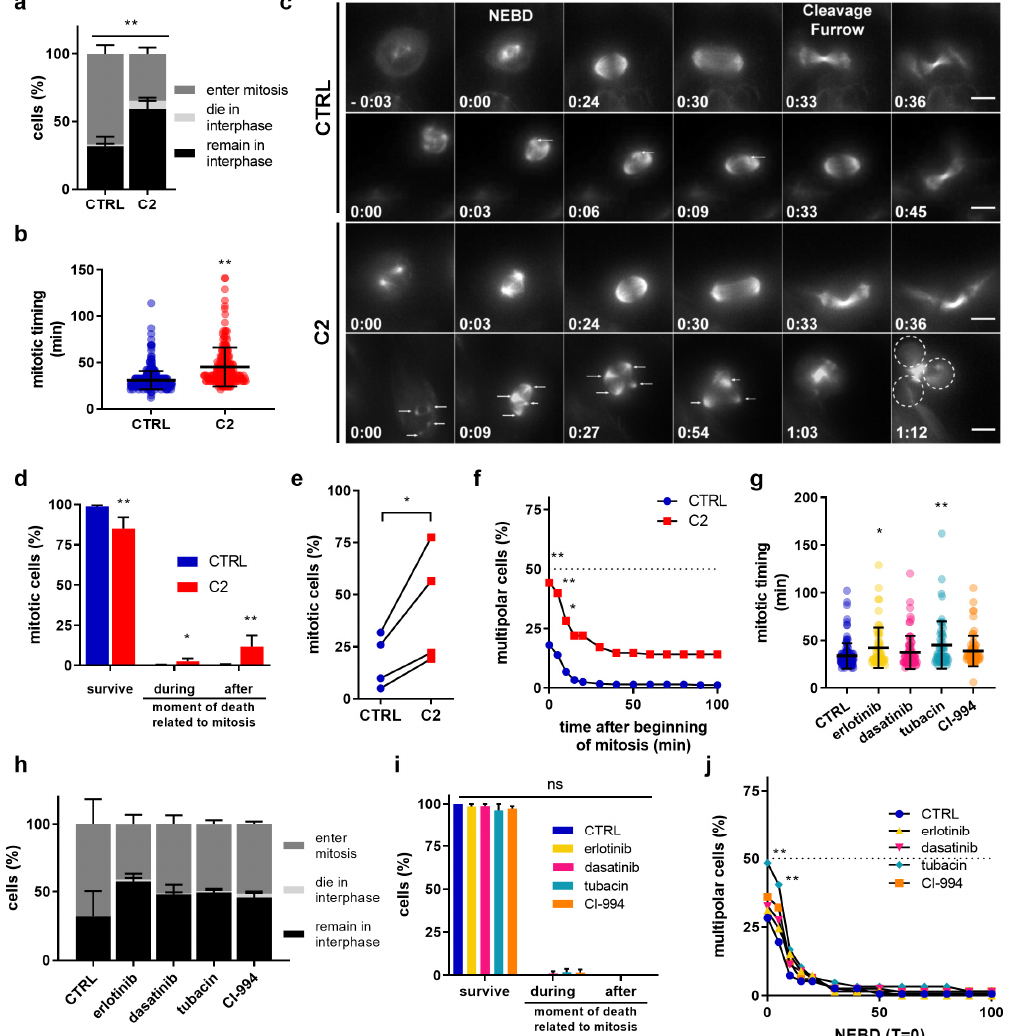
Figure 3. C2 prevents centrosome clustering in 786-O cells during metaphase. ( a ) Outcomes of 786-O cells treated with CTRL (0.1% DMSO) or C2 during 24h movies. ** p < 0.0001 vs. CTRL in a Fisher’s exact test, N = 4 experiments with n = 606 (CTRL) and n = 603 ( C2 ) cells ( b ) Mitotic timing is defined as the time between nuclear envelope breakdown (NEBD) and cleavage furrow formation. ** p < 0.001 vs. CTRL in a Mann–Whitney Test from N = 4 independent experiments with a total of n = 206–406 cells. ( c ) Time-lapse images of CTRL (0.1% DMSO) or C2 -treated 786-O cells undergoing mitosis, stained with SiR-Tubulin. Mitotic timing in h:mins using nuclear envelope breakdown (NEBD) as T = 0. The arrows in the C2 -treated multipolar cells indicate spindle poles, dashed circles the daughter cells after mitotic completion. Scale bar = 10 µm. ( d ) Mitotic outcomes of 786-O cells treated with CTRL (0.1% DMSO) or C2 . ** p < 0.0001 and * p < 0.05 vs. CTRL in a Fisher’s exact test, N = 4 independent experiments with n = 406 (CTRL) and n = 206 ( C2 ) cells. ( e ) Percentage of multipolar cells in individual experiments. * p < 0.05 vs. CTRL in paired two-tailed T-test from N = 4 independent experiments; n = 406 (CTRL) and 206 ( C2 ) cells. ( f ) Percentage of multipolar cells over time. ** p < 0.005 and * p < 0.05 for the first three points compared to CTRL in a two-way ANOVA with Sidak’s multiple comparisons test from N = 4 independent experiments with n = 406 (CTRL) and n = 206 ( C2 ) cells. ( g ) Mitotic timing of 786-O cells treated with the single drugs used for C2 . Significances of ** p = 0.0008 and * p = 0.0236 vs. CTRL group in a two-way ANOVA with Tukey’s multiple comparisons test from N = 4 experiments with n = 62–123 cells. ( h ) Outcomes of 786-O cells treated with CTRL or monotherapies